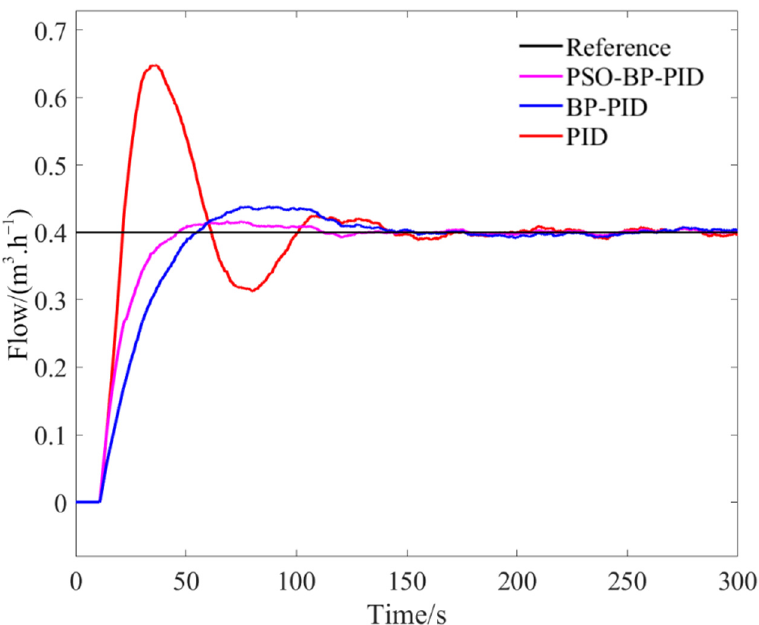
Figure 12. Regulation curves of three controllers at fertilizer application flow rate of 0.4 m 3 /h.